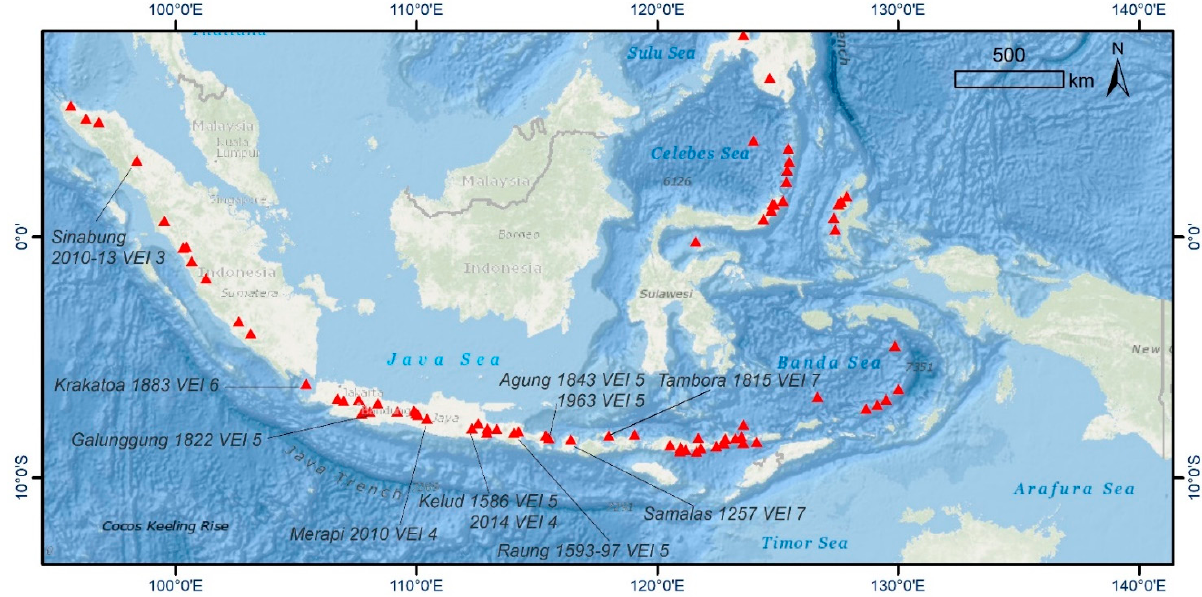
Figure 1. Distribution of active volcanoes in Indonesia. Several volcanoes create remarkable eruption by the range of VEI 3–7 (list of VEI data Refs.: [17,18]).